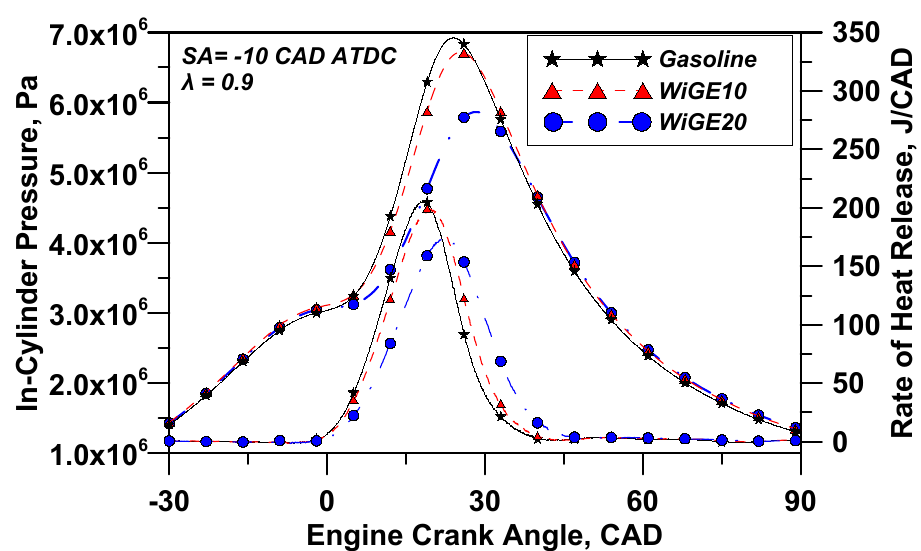
Figure 2. In-cylinder pressure trace and rate of heat release at SA = − 10 CAD ATDC, λ = 0.9.